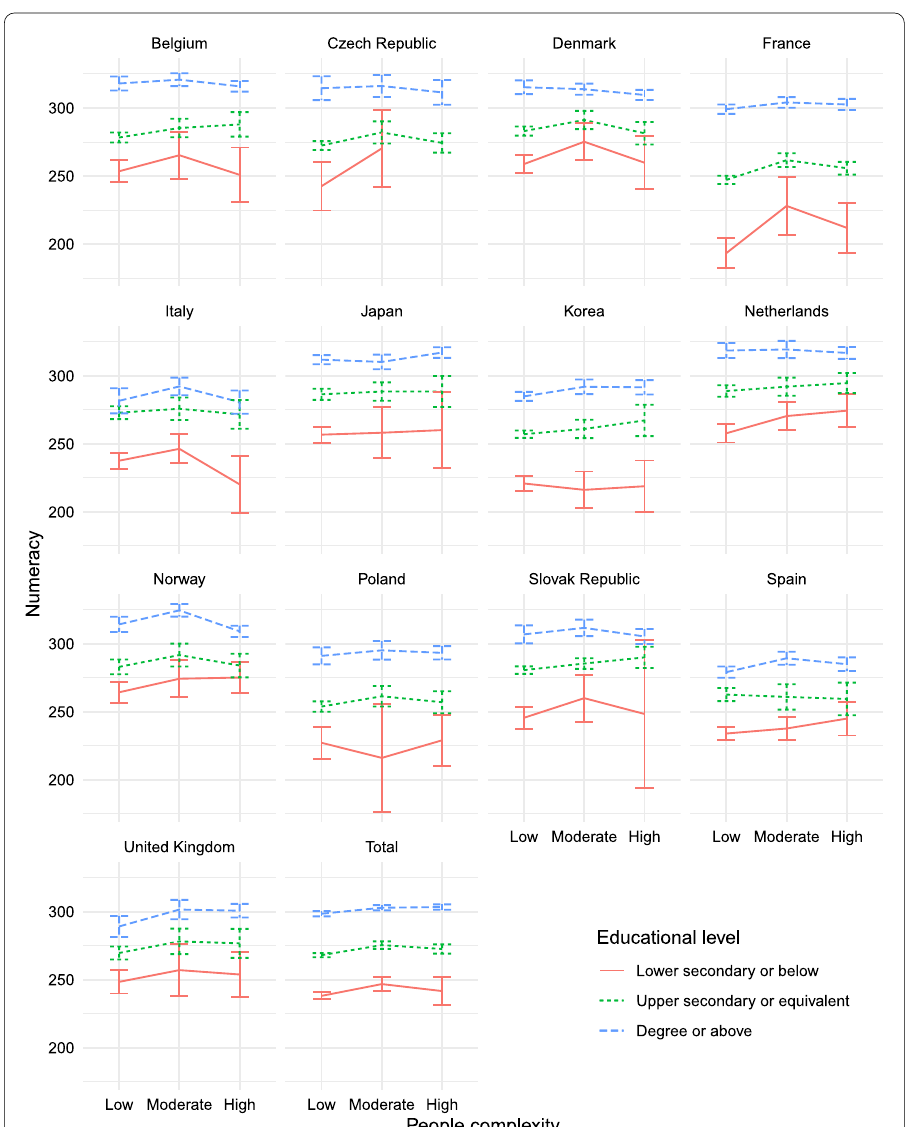
Fig. 3 Relation of complexity with people to numeracy scores among native born full-time employees in age group 25–65 years in 13 PIAAC countries, for each educational level. Error bars depict 95 % confidence intervals. Source: PIAAC 2012, DOT index, ISCO-08